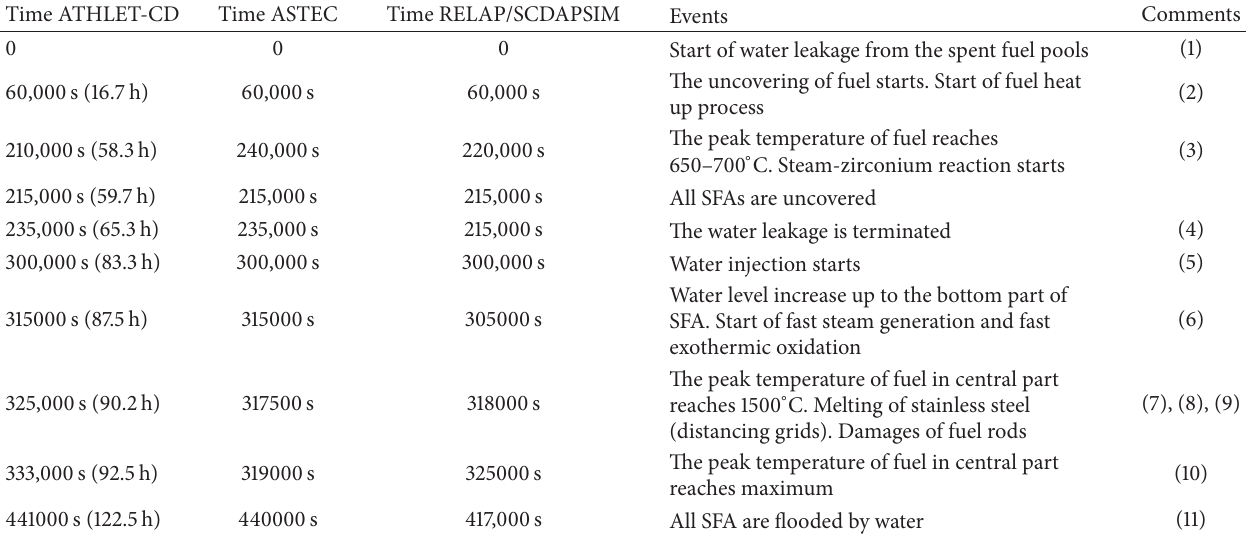
Table 4: Sequence of events, in the case of water leakage from spent fuel pools of Ignalina NPP.